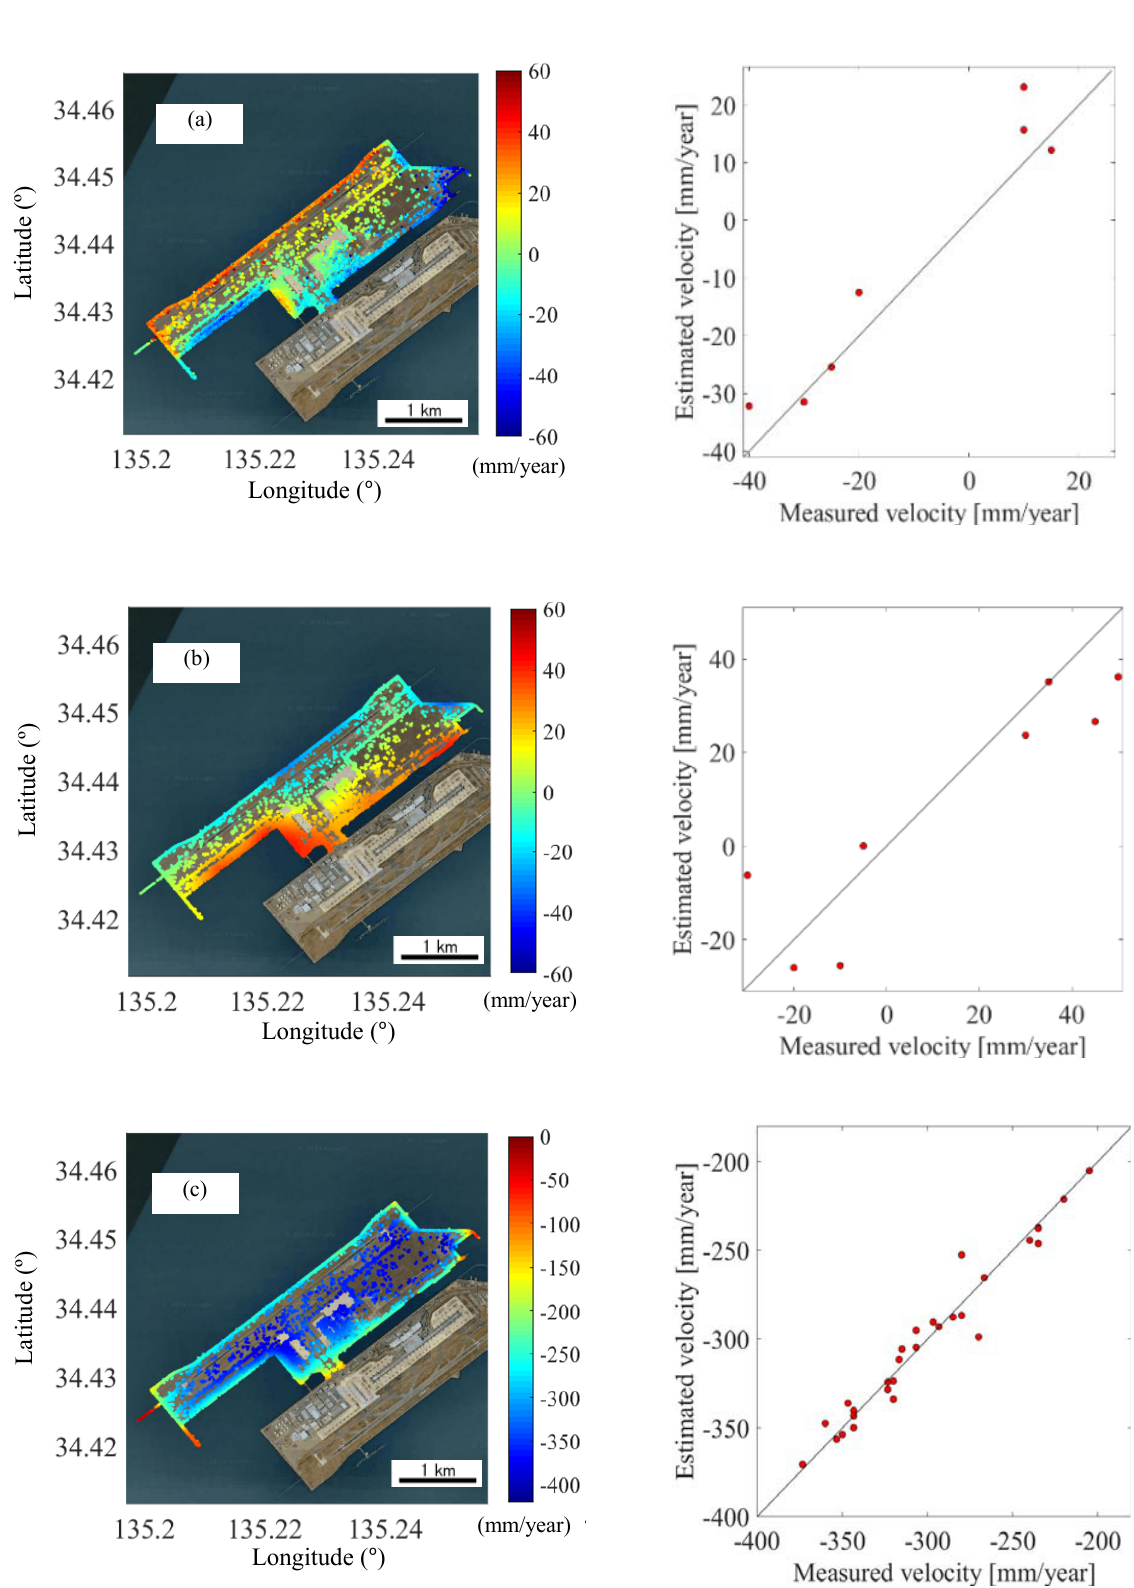
Figure 9. Integration results: (a) east–west, (c) north–south, and (e) vertical components of displacement shown in units of mm/year. Validation results: (b) east–west, (d) north–south, and (f) vertical components. Map data ©2020 Google,